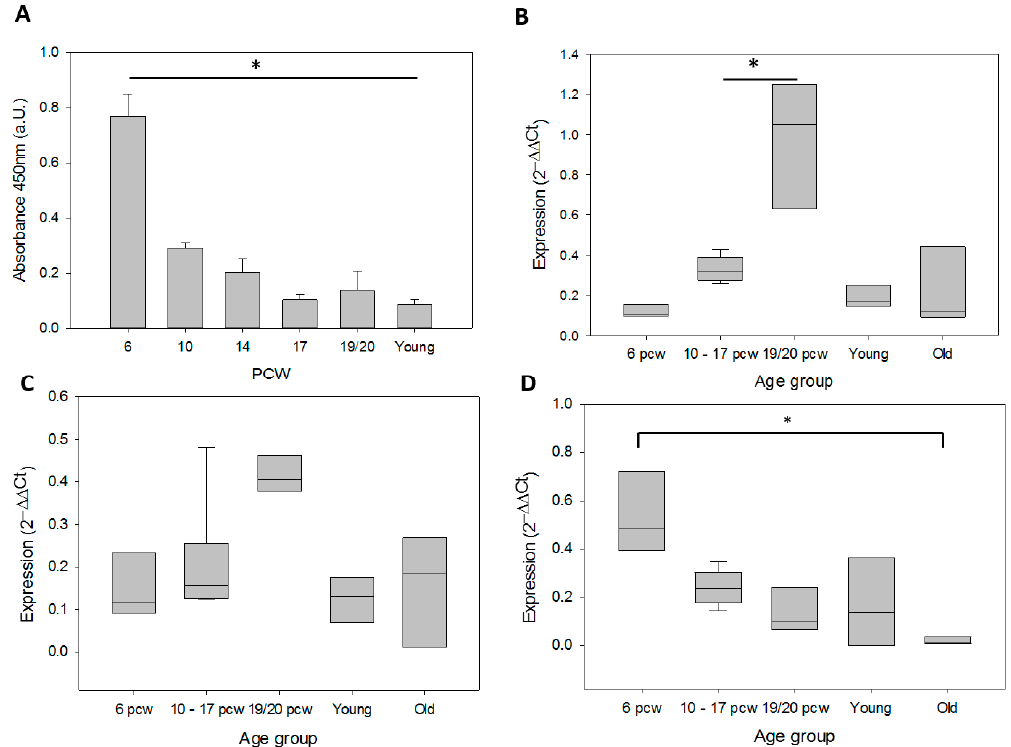
Figure 1. Telomerase activity and expression of telomerase-related genes in fetal brain, young and old cortices. ( A ) Telomerase activity, mean and SD, TA at 6 pcw was significantly different from all other